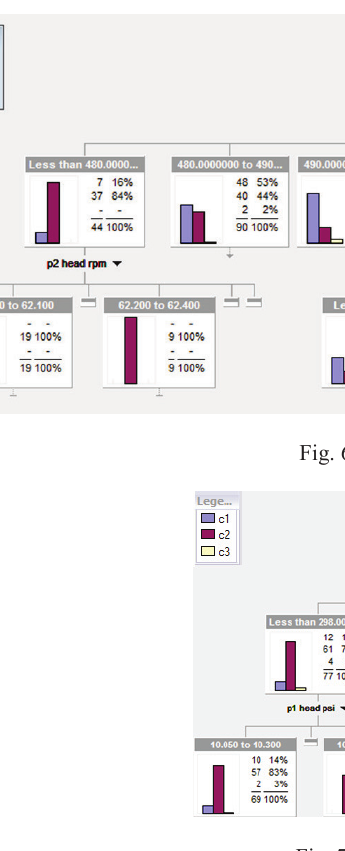
Fig. 7. Decision Tree 1 for Stage